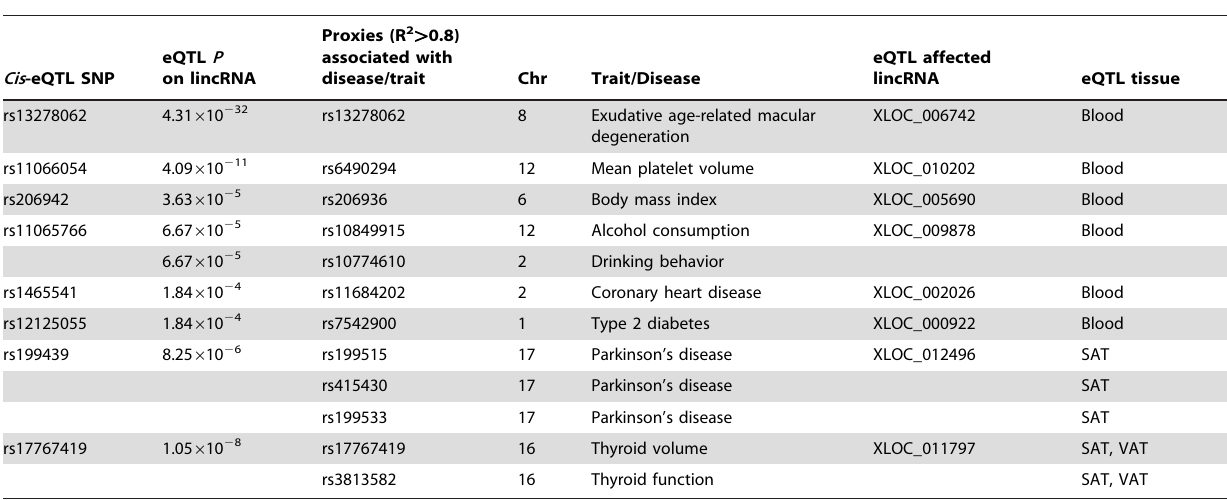
Table 1. Some of the lincRNA cis -eQTLs are disease-associated SNPs.